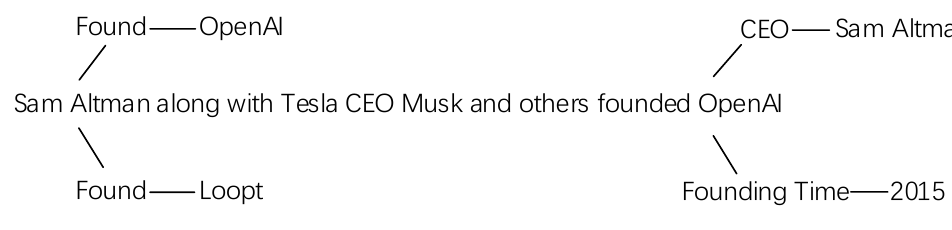
Figure 5. Example tree structure diagram. The text relation is the relation tree trunk, Sam Altman and OpenAI are the related entity, and the triple is the relation tree branches.